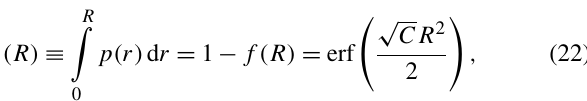
Figure 5. The mode radius versus the supersaturation for h = 1m as given by Eq.